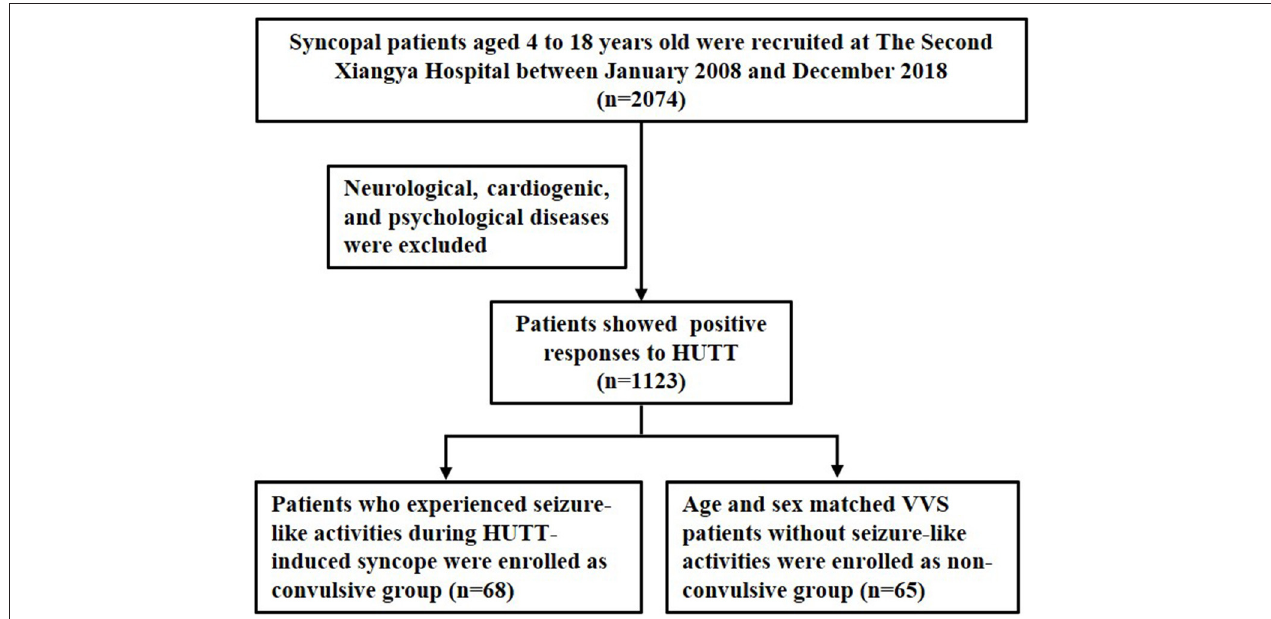
FIGURE 1 | Flow chart of the study population